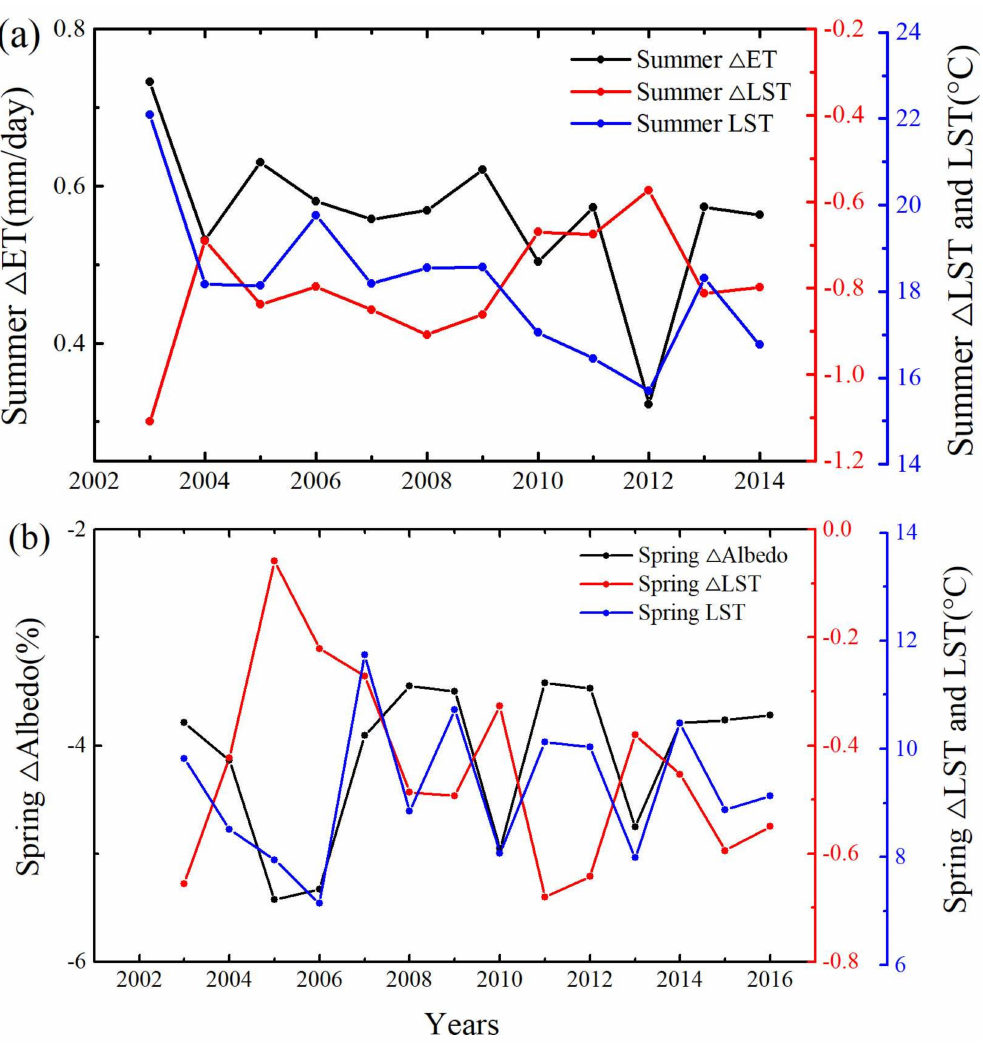
Figure 13. Interannual variability of ( a ) the seasonal mean LST in summer, the difference in ET (forest minus open land) in summer, and background LST in summer and ( b ) the seasonal mean LST in spring, the difference in albedo (forest minus open land) in spring, and the background LST in